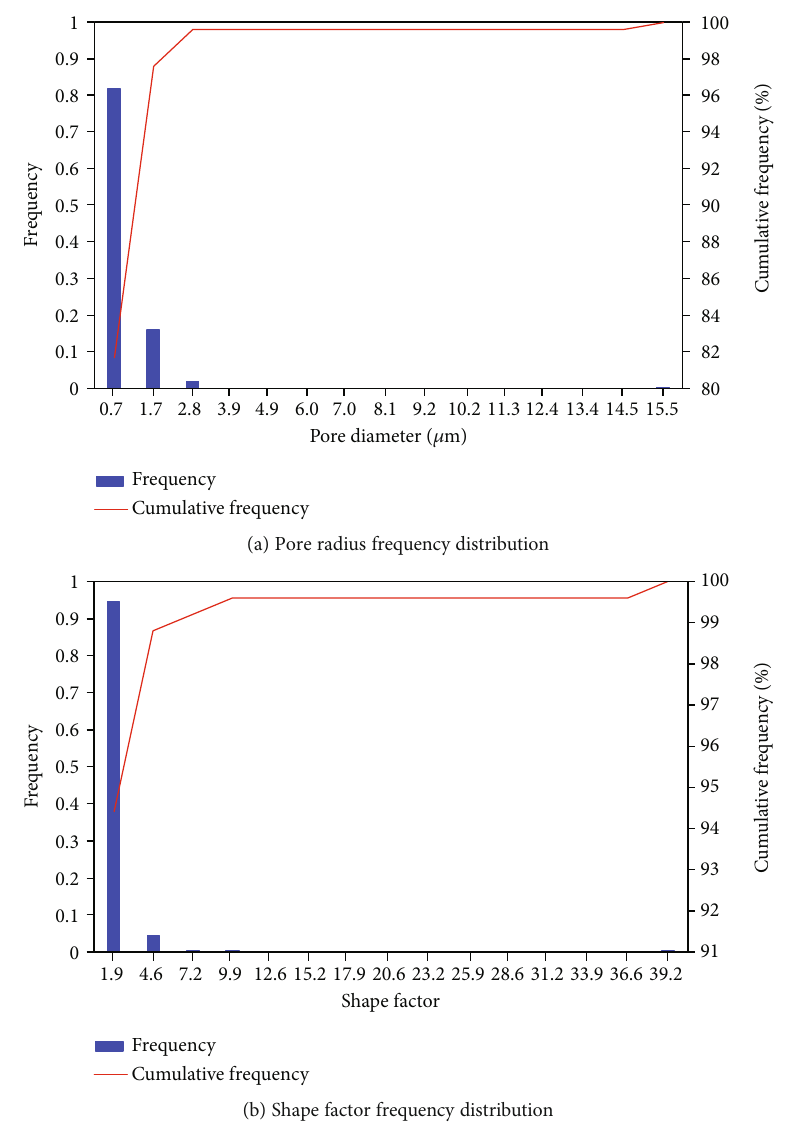
Figure 8: Statistical parameters of the real deformation